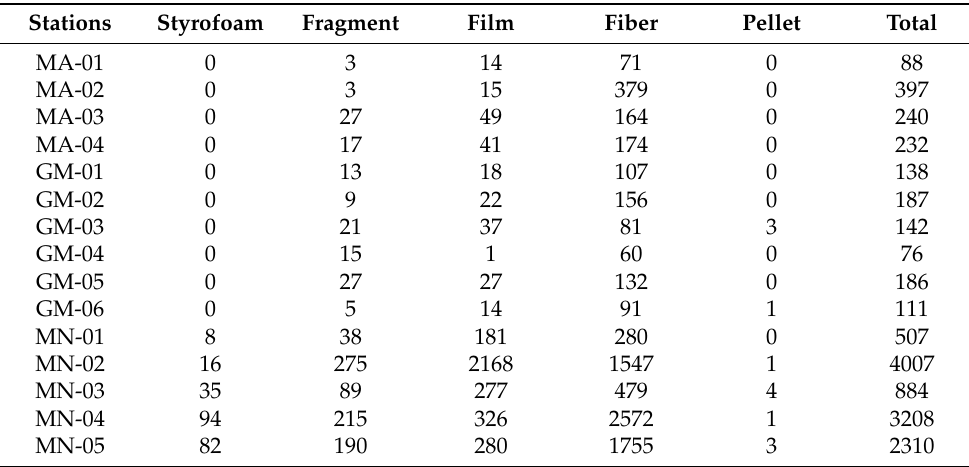
Table 2. Quantity of microplastics and morphology found per